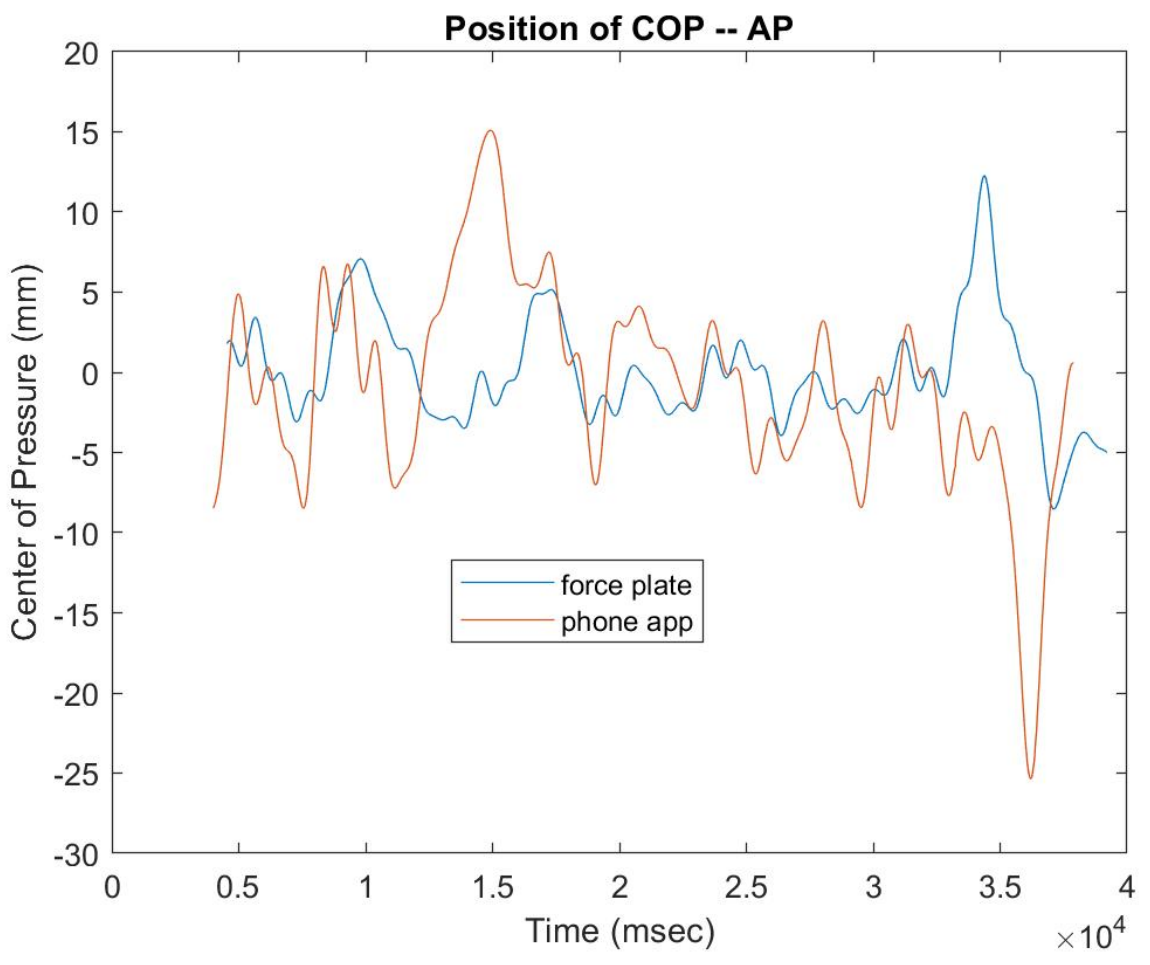
Figure 2. Typical plots of the position of center of pressure (COP) in the anterior-posterior direction as calculated from the data acquired by the force plate and the phone application.